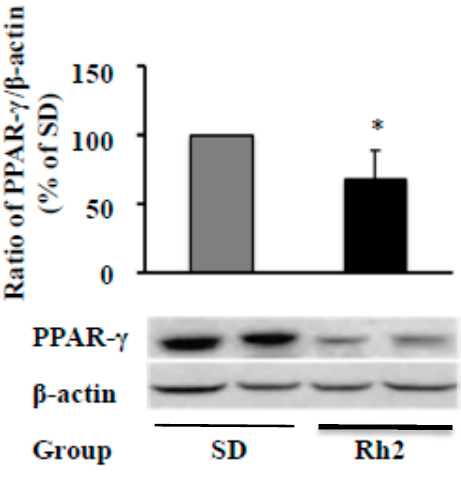
Figure 6. In vivo effects of dietary ginsenoside Rh2 intake. After an eight-week dietary administration of Rh2 (0.1 g/kg diet), the liver PPAR- γ protein expression in mice was determined by Western blot and normalized to β -actin expression. Values are means ± SE, n = 12. A set of representative images and bar graphs are shown. * p < 0.05 vs. standard diet (SD).